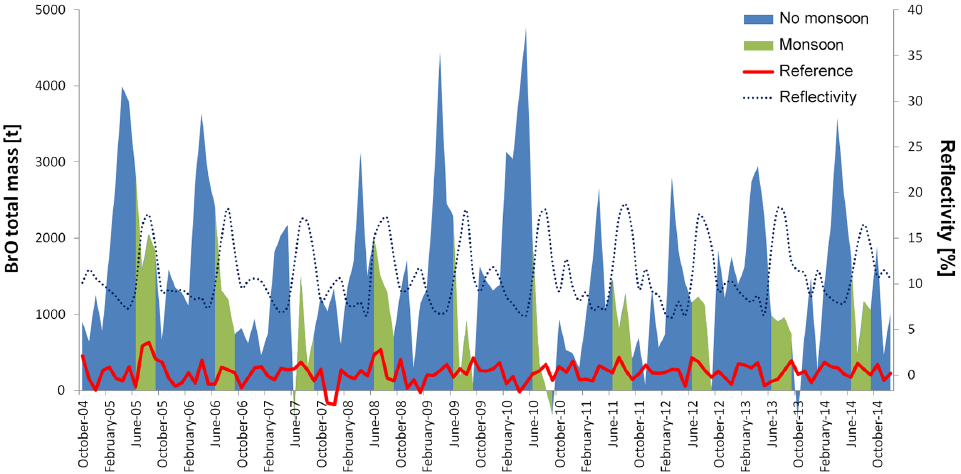
Figure 5. Total BrO mass over the Rann of Kutch area calculated from monthly averaged BrO VCD OMI data for the baseline scenario (i.e. a homogeneous layer reaching from the surface up to 1km) from October 2004 until December 2014. During monsoon months (green) the reflectivity (blue dotted line) shows maximum values due to cloud coverage, while the BrO mass is lowered (partly due to cloud shielding). Maximum BrO masses are typically accompanied by a rather low reflectivity. For comparison, BrO masses obtained over a corresponding reference area of the same size directly west of the considered region are indicated by the red